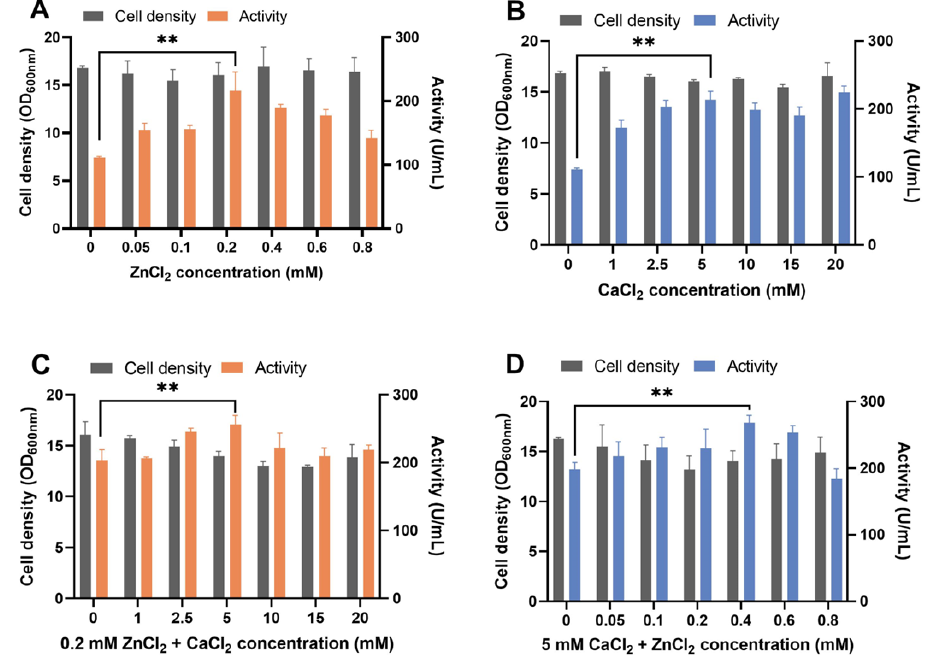
Figure 1. Recombinant pseudolysin expression optimization by adding ZnCl 2 and CaCl 2 to the YPD medium. ( A ) Effect of supplement with different concentrations of ZnCl 2 (0–0.8 mM) in YPD medium on B_lasB2 strain cell density and proteolytic activity. ( B ) Effect of supplement at different concentrations of CaCl 2 (0–20 mM) in YPD medium on B_lasB2 strain cell density and proteolytic activity. ( C ) Effect of supplement at 0.2 mM ZnCl 2 and 0–20 mM CaCl 2 in YPD medium on B_lasB2 strain cell density and proteolytic activity. ( D ) Effect of supplement with 5 mM CaCl 2 and 0–0.8 mM ZnCl 2 in YPD medium on B_lasB2 strain cell density and proteolytic activity. ** p < 0.01.